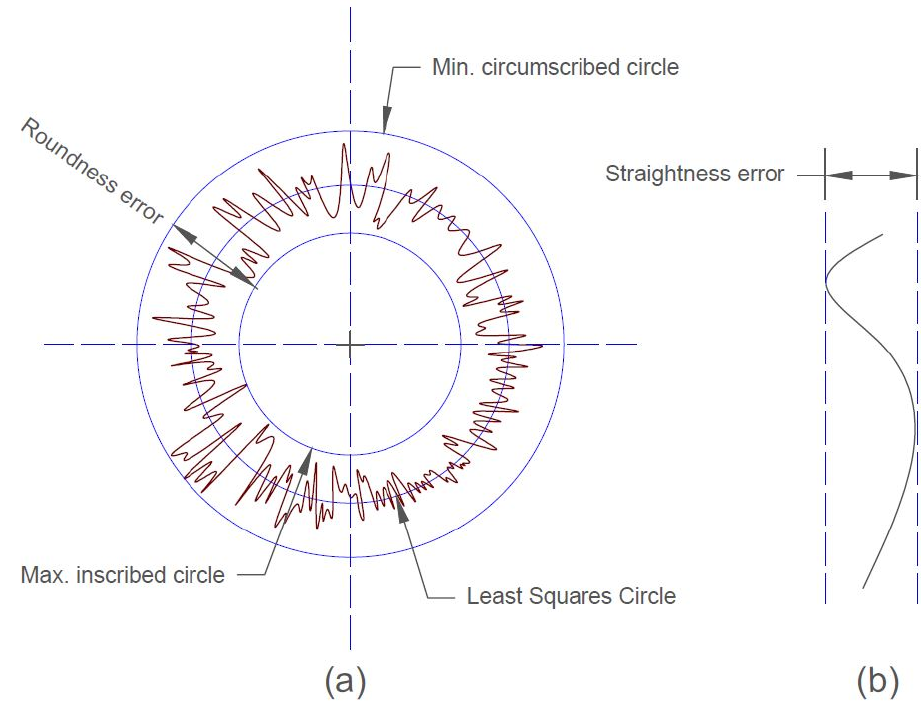
Figure 6. ( a ) Roundness error; ( b ) straightness error.